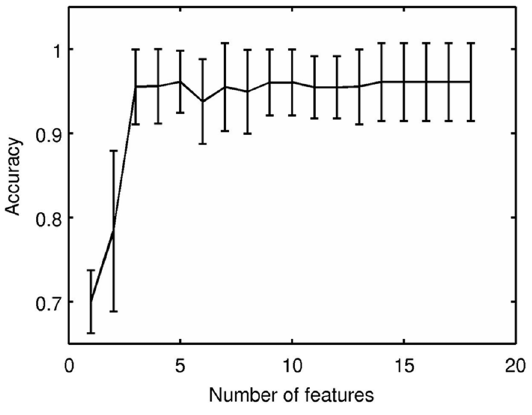
Figure 3. Average accuracy of SVM, as a function of number of features. For each r=1,2,…,18, line 3 of FS_SVM (Figure 2)